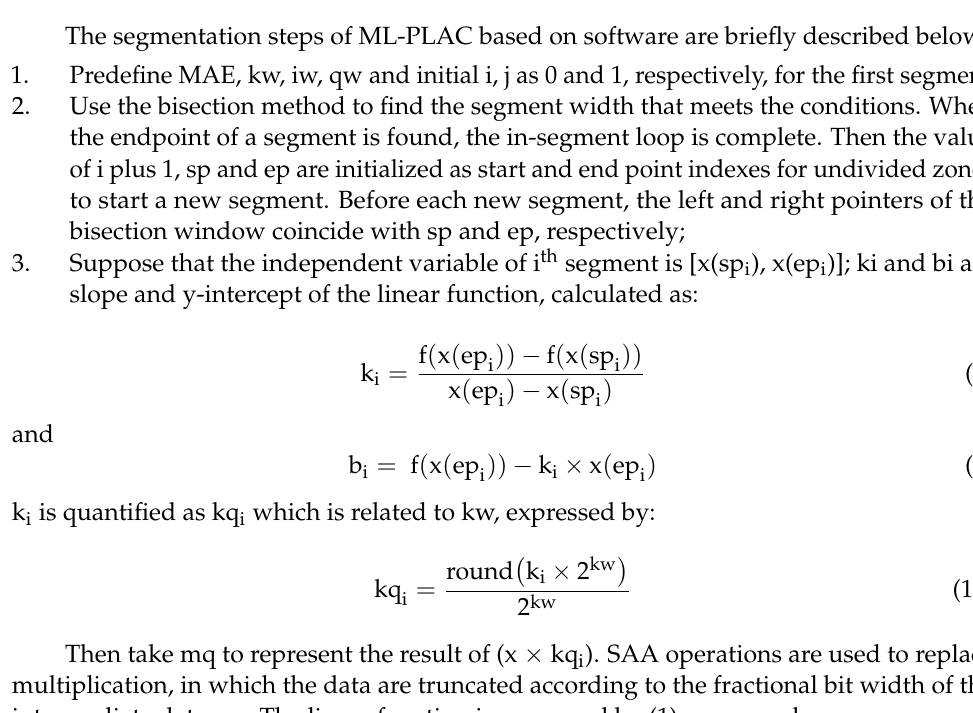
Figure 3. The process of segmentation in ML ‐ PLAC.